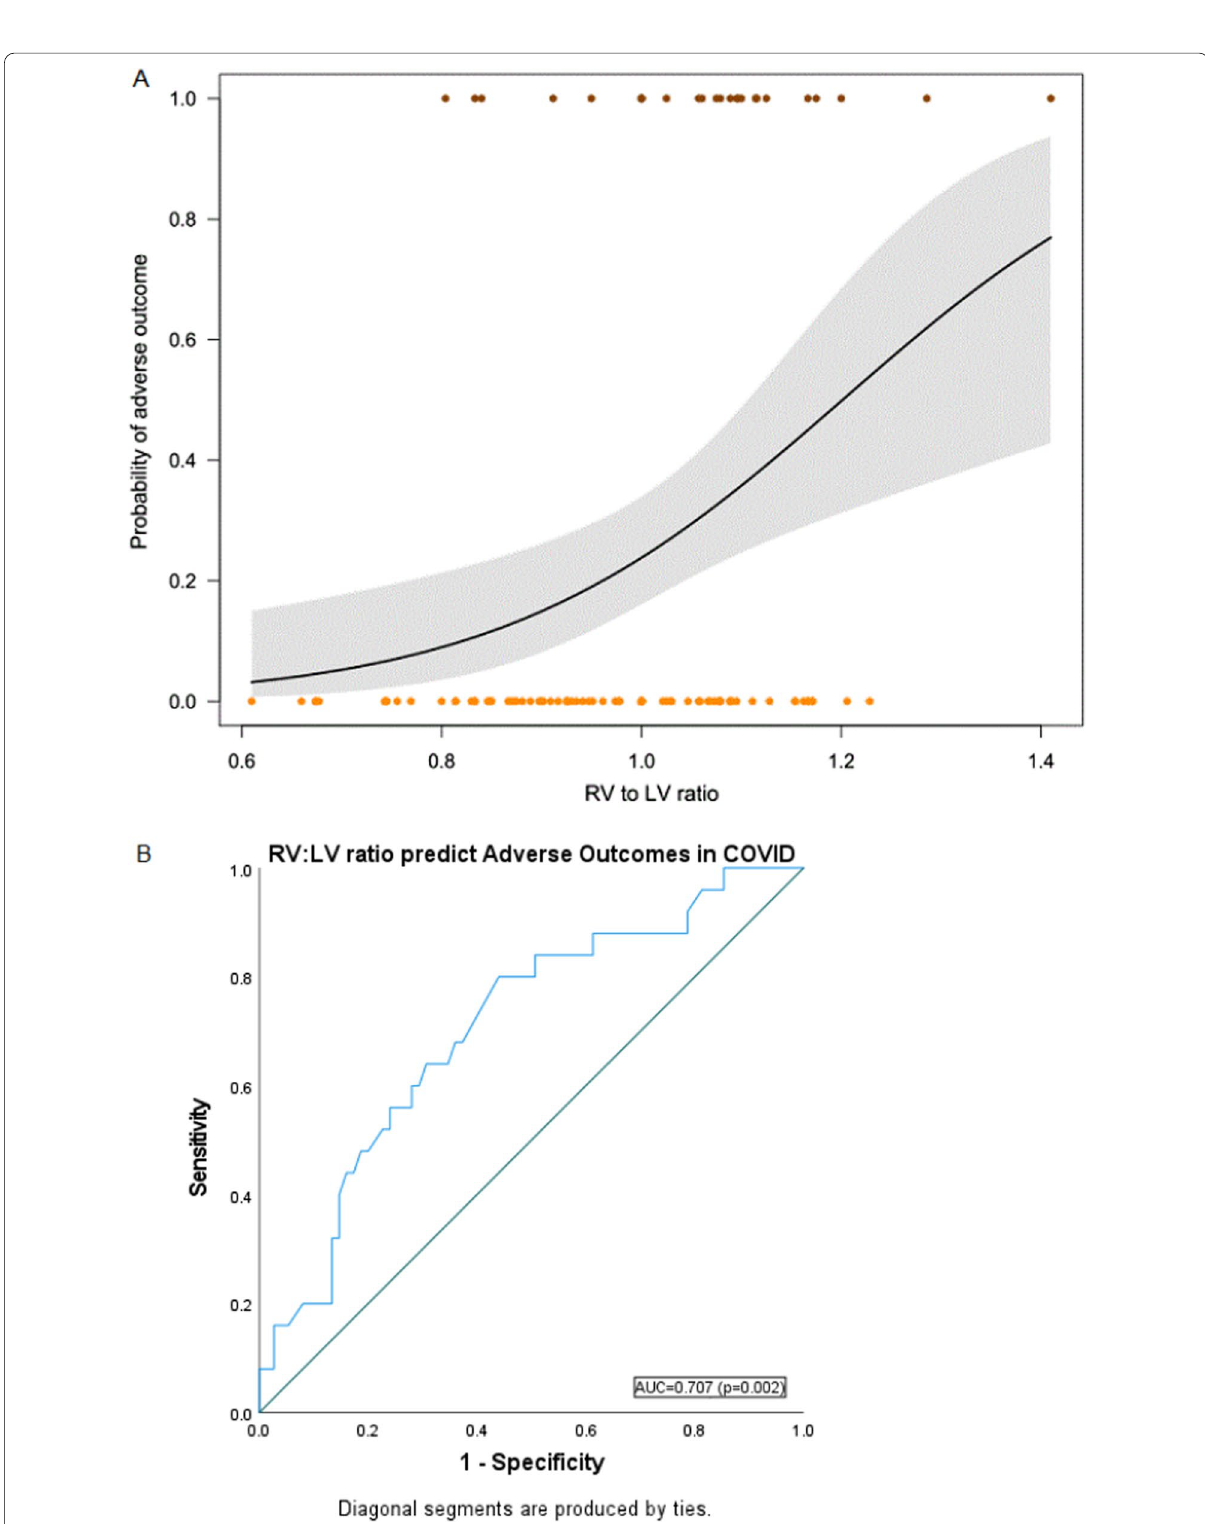
Fig. 4 Correlation of RV:LV ratio with the probability of adverse outcomes (death, intubation, ICU admission) in COVID-19 cohort. A logistic regression (dots represent data: BROWN dots: adverse outcomes, ORANGE dots: no adverse outcomes; RV:LV ratio on the x -axis; black line represents the fit of the logistic regression, gray polygon represents 95% confidence interval). B Receiver operator curve of RV:LV ratio predicting adverse outcomes (AUC 0.707, p 0.002, CI 0.59–0.82, Optimal cutoff 1.1) . RV right ventricle, LV left ventricle, COVID-19 novel = = =